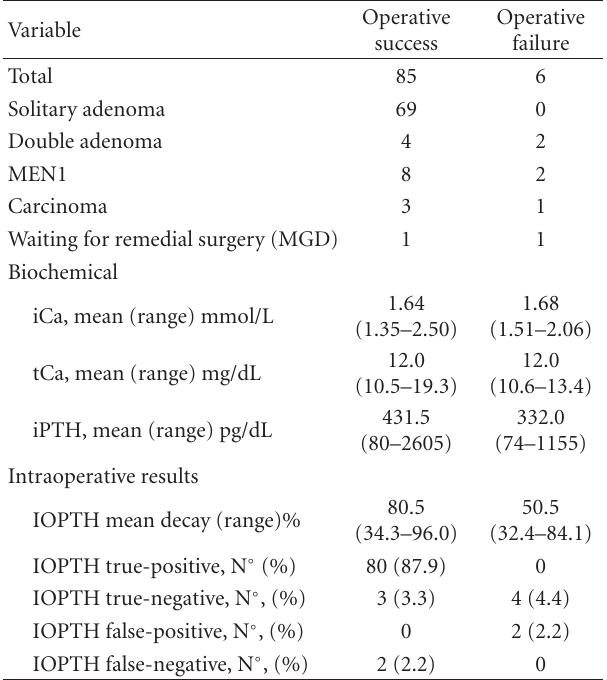
Table 2: Outcomes in 91 PHP